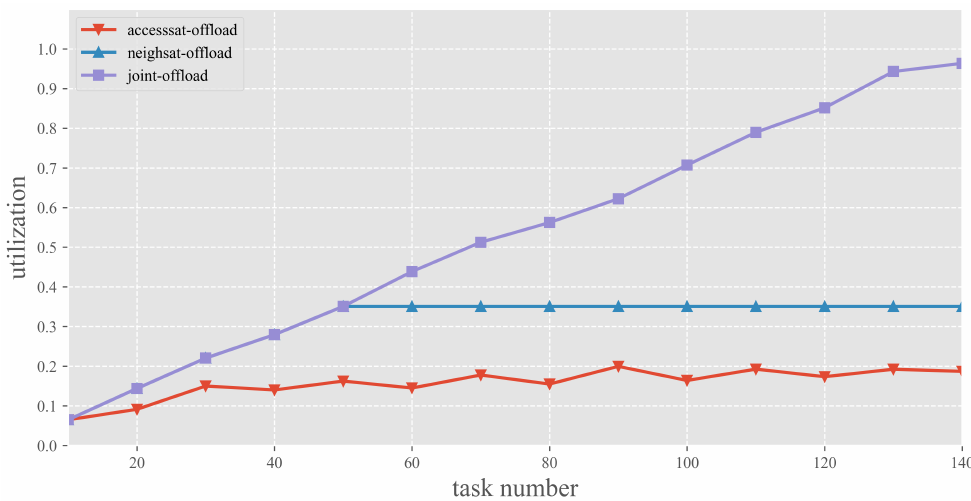
Figure 8. The maximum utilization of satellites computing resources in different LEO constella- tion sizes.